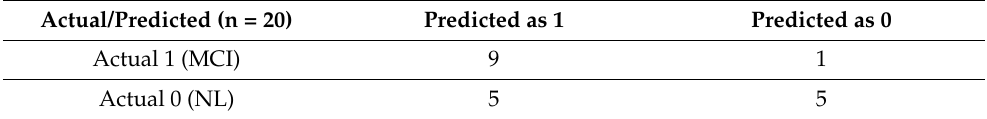
Table 8. Confusion matrix of MCI/NL classification with the hippocampal region.